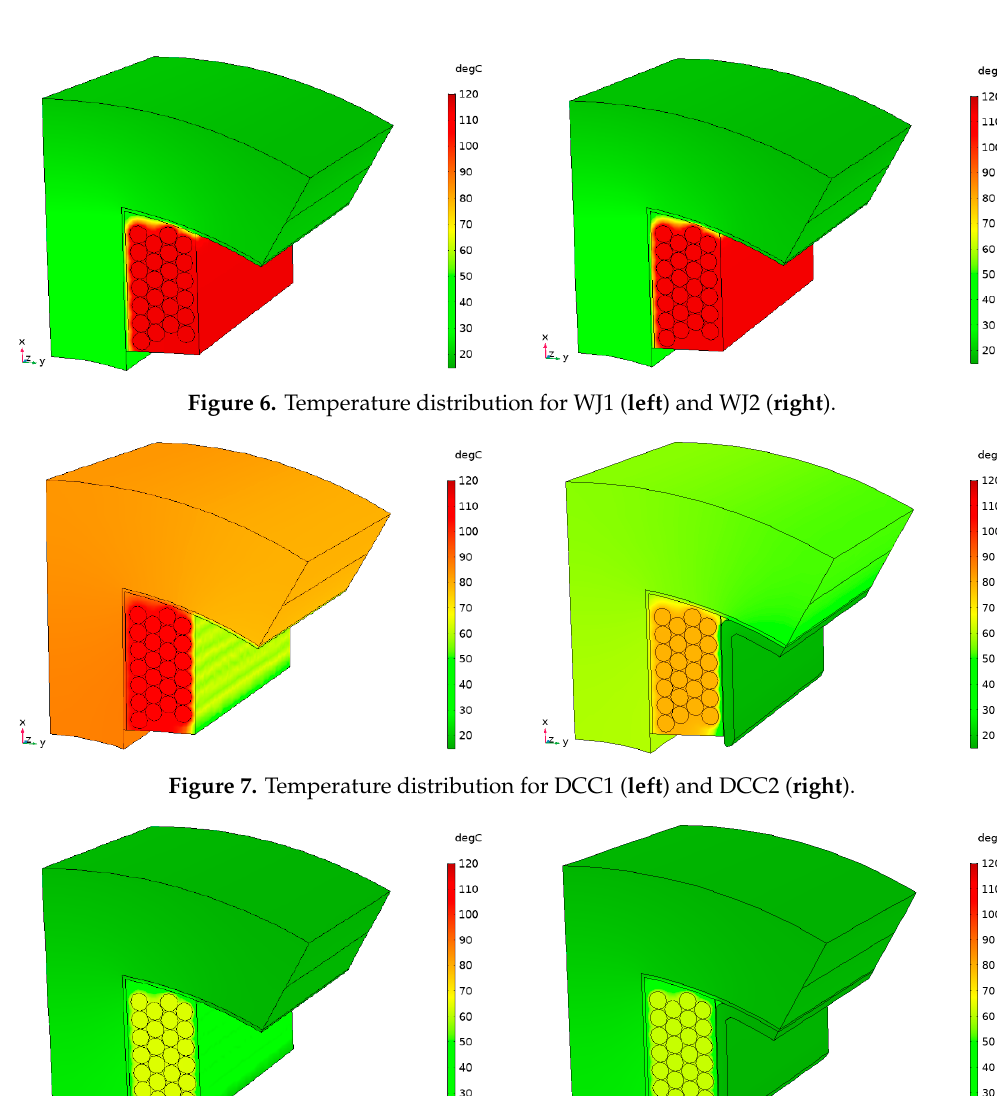
Figure 6. Temperature distribution for WJ1 ( left ) and WJ2 ( right ).